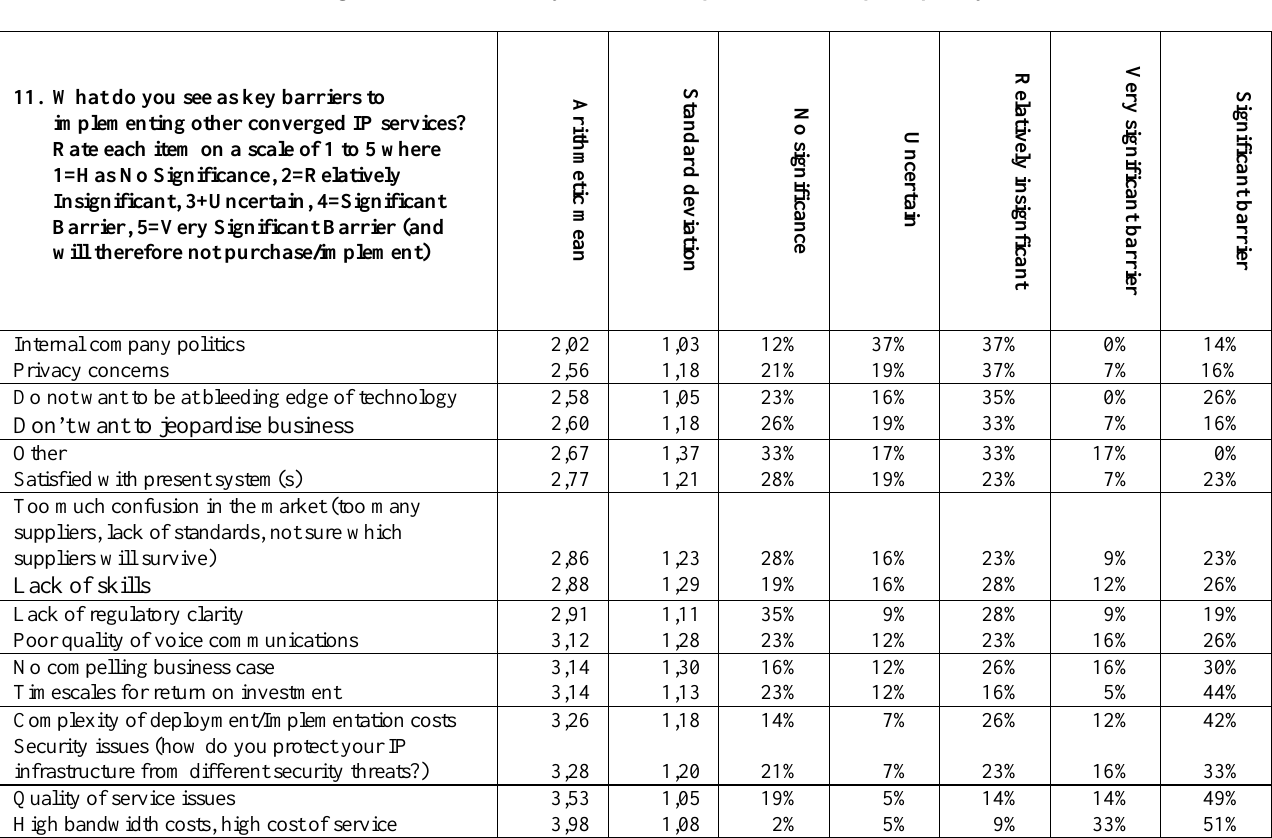
Figure 1: Factors likely to affect adoption of VoIP/Ip telephony